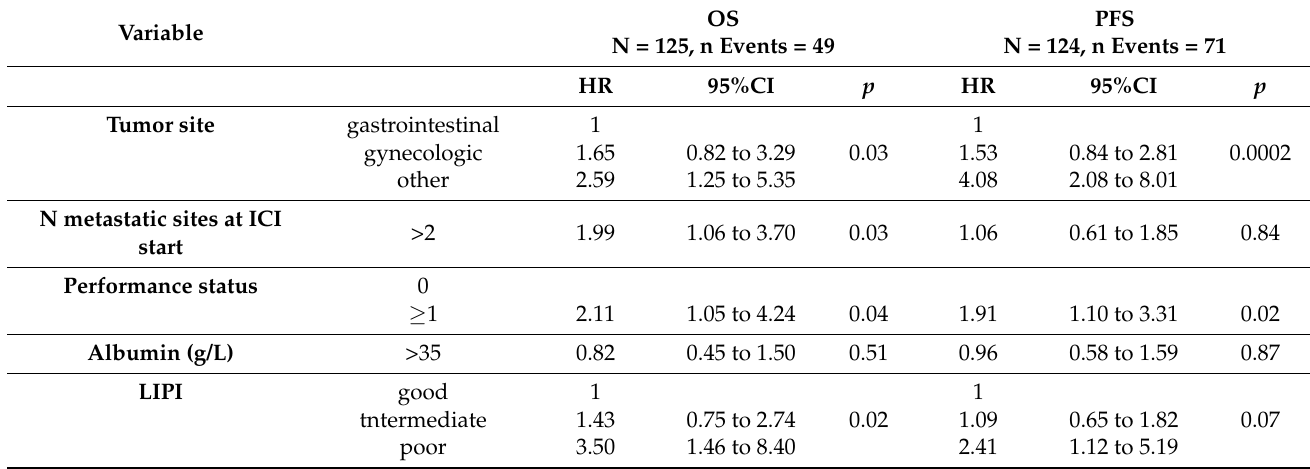
Table 3. Multivariate Cox model analysis for OS and PFS in the population.